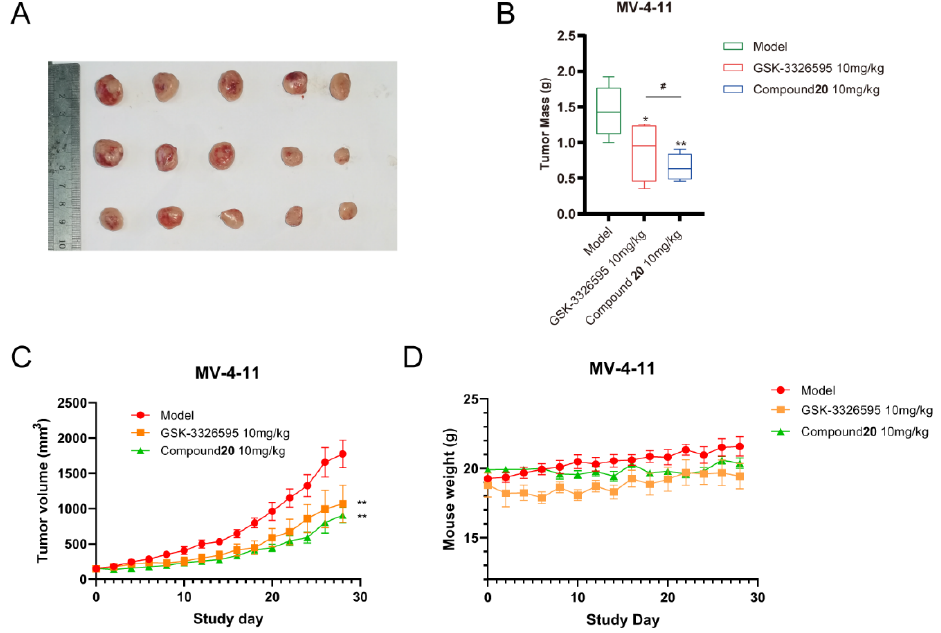
Figure 6. Effects of GSK-3326595 (10 mg · kg − 1 , iv) and compound 20 (10 mg · kg − 1 , iv) treatment on the tumorigenicity of MV-4-11 cells in vivo. ( A ) The resulting tumors excised from the animals after treatment. ( B ) The tumor masses for three groups of animals were compared, and each histogram represents the Mean ± SD of 5 mice. * p < 0.05 vs. model, ** p < 0.01, # p < 0.05 vs. GSK-3326595 . ( C ) The nude mouse body weight was measured every 2 days. ( D ) The tumor volumes of the nude mice were measured and calculated once every 2 days.